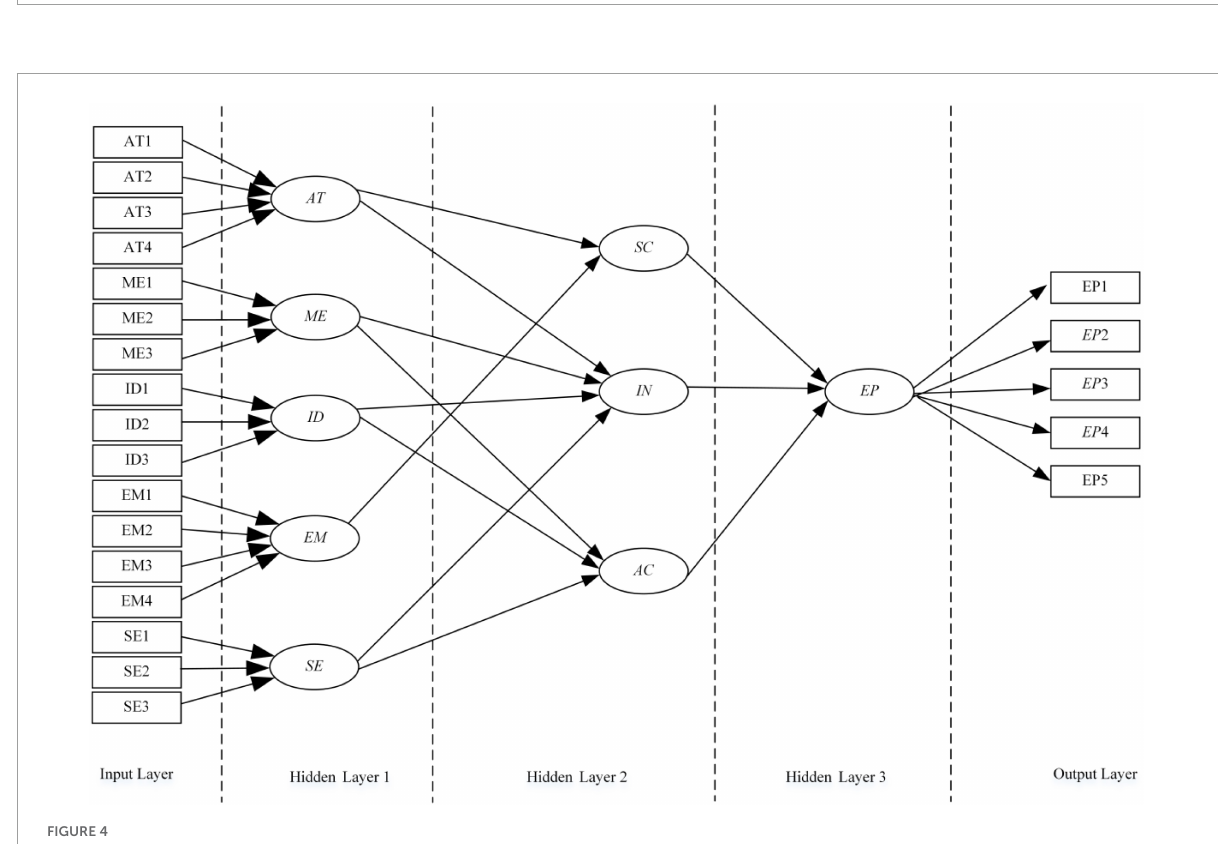
FIGURE4 A structured neural network model